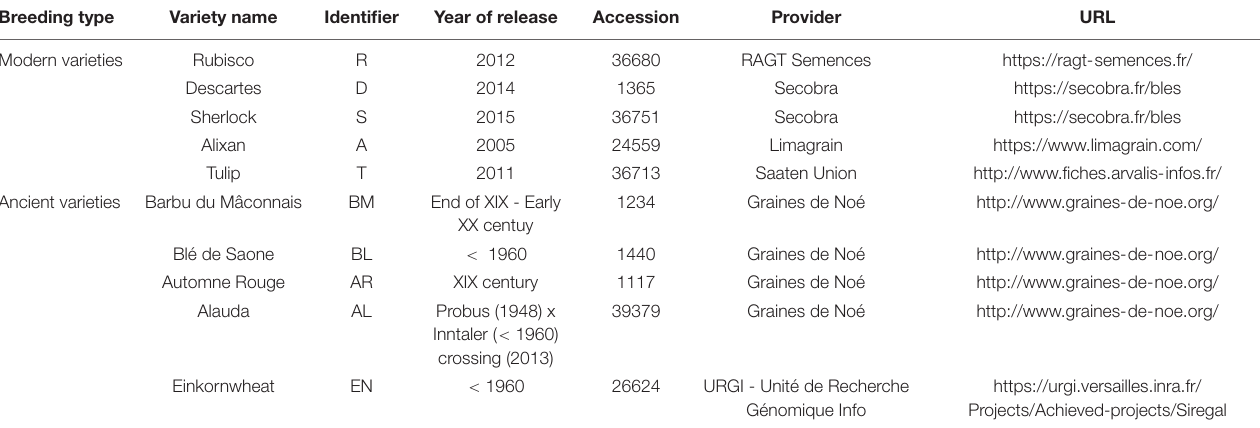
TABLE 1 | Detailed list of modern and ancient wheat varieties used in this study.